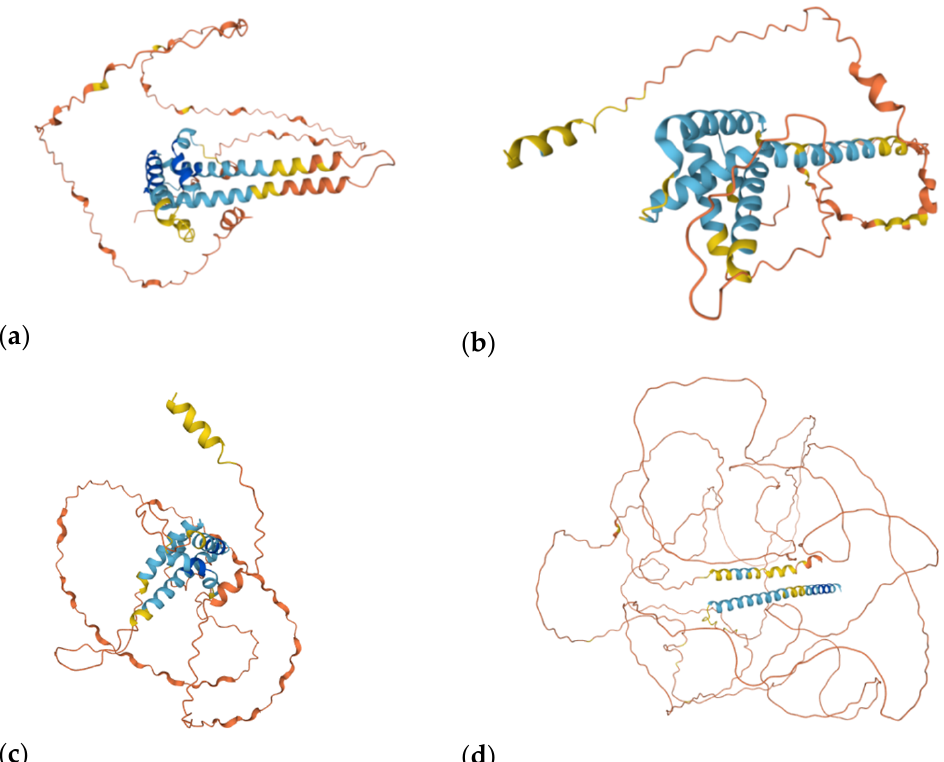
Figure 1. Gluten structure from the UNIPROT database https://www.uniprot.org/ (accessed date 31 January 2022) [6]. The picture shows ( a ) glutenin LMW subunit; ( b ) α,β-gliadin; ( c ) γ-gliadin; ( d ) glutenin HMW subunit. AlphaFold produces a per-residue confidence score (pLDDT) between 0 and 100. Some regions with low pLDDT may be unstructured in isolation. The colours represent the model confidence: dark blue–Very high (pLDDT > 90); light blue–Confident (90 > pLDDT > 70); yellow –Low (70 > pLDDT > 50); red–Very low (pLDDT < 50).